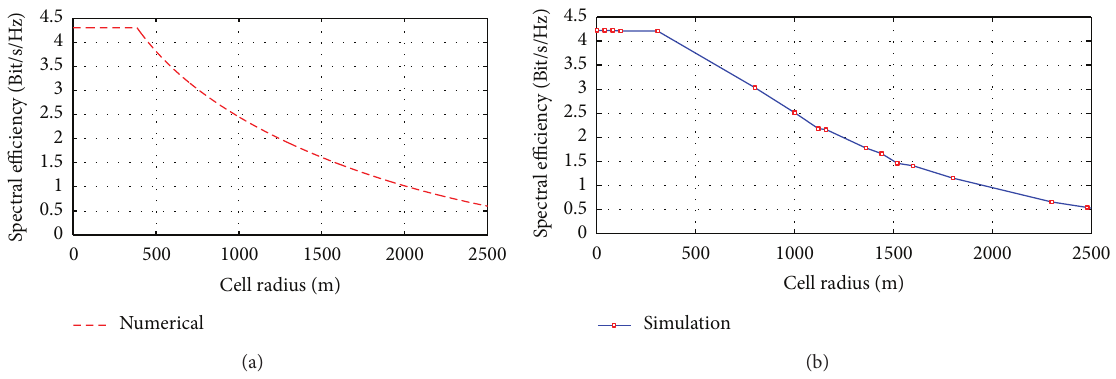
Figure 6: Spectral efficiency versus the cell radius: (a) numerical results and (b) ATDI simulation results.